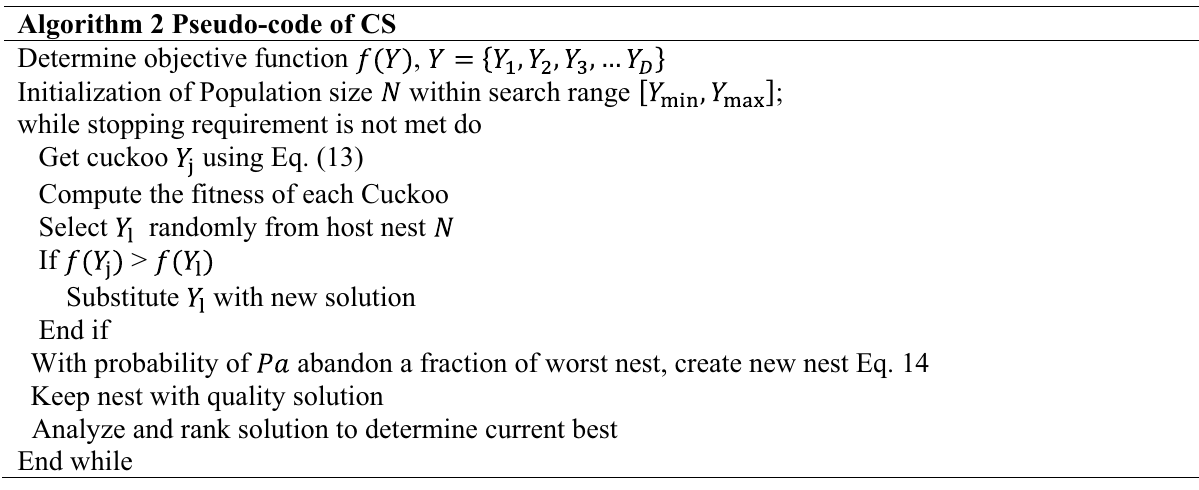
Algorithm 2 Pseudo-code of